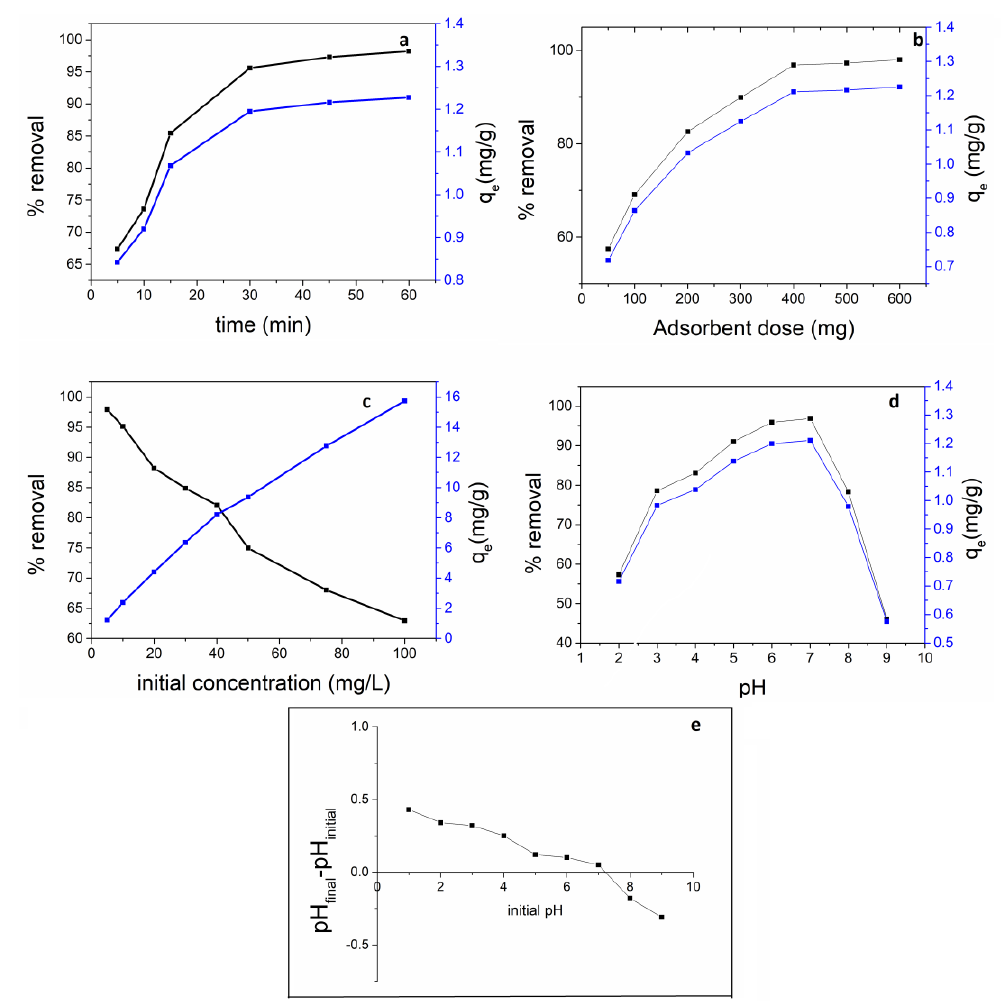
Figure 5. Optimized parameters: ( a ) contact time, ( b ) CSn dose, ( c ) Initial concentration, ( d ) pH, and ( e ) pH point of zero charge.